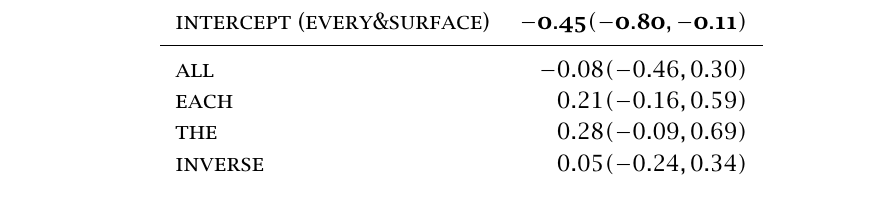
Experiment 1 (in context): Coefficients & 95 % CIs for the linear mixed model of the full-sentence (summed) residualized log